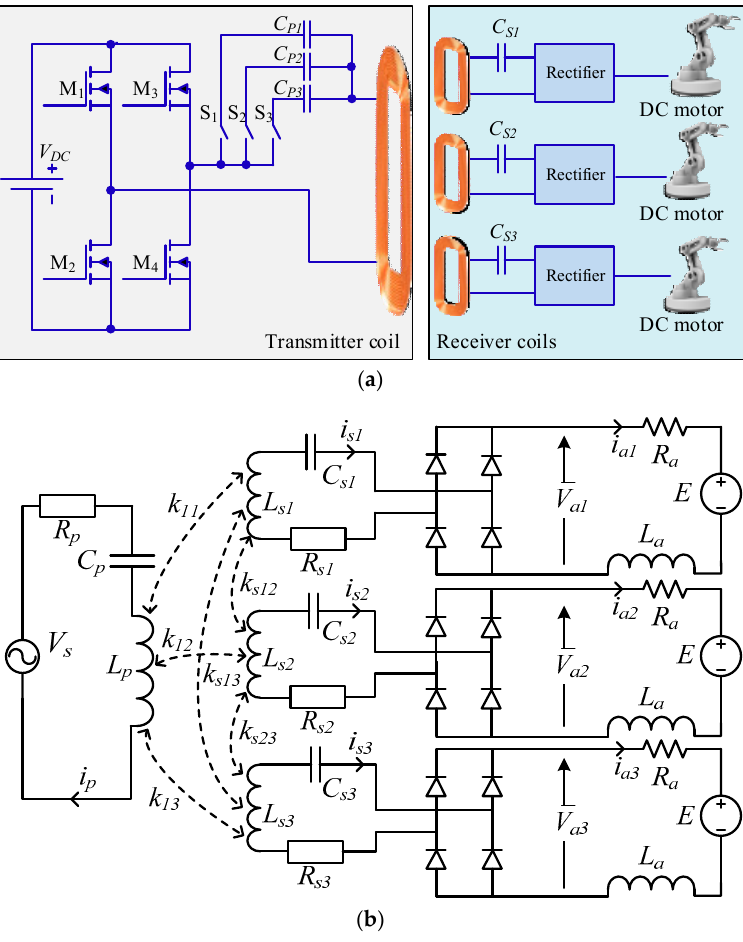
Figure 1. Wireless DC motor drive system: ( a ) schematic; and ( b ) model.